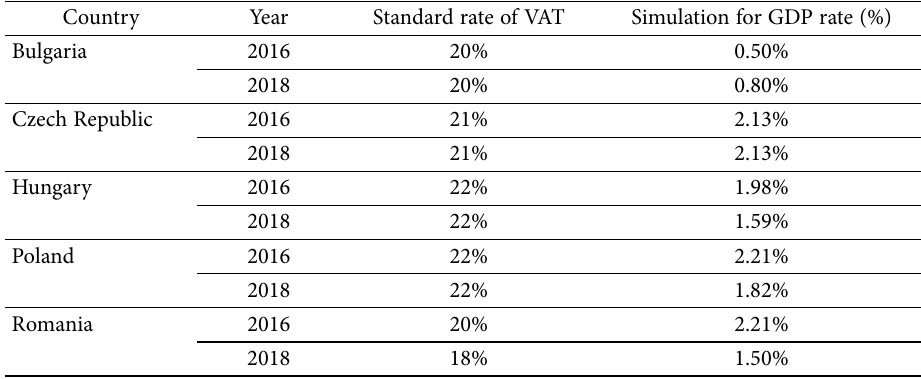
Table 6. Simulations of GDP rate in CEE-5 countries using dynamic panel model Country Year Standard rate of VAT Simulation for GDP rate (%) 2016